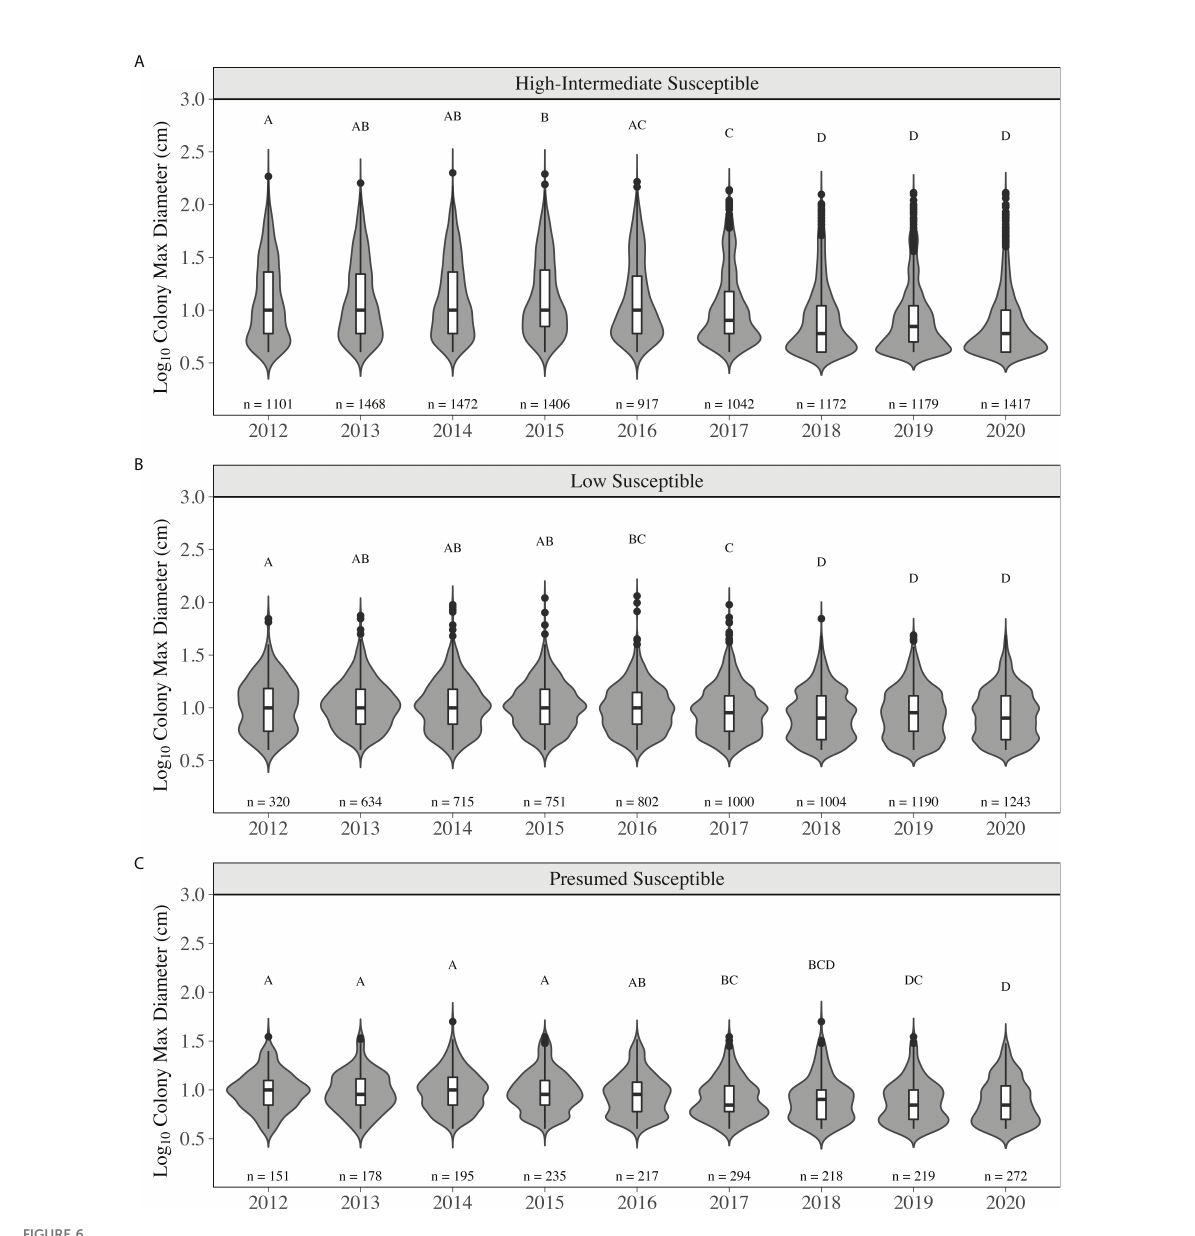
FIGURE 6 Colony max diameter from 2012-2020 for stony coral species based on SCTLD susceptibility categorization for (A) high-intermediate susceptible species (B) low susceptible species and (C) presumed susceptible species. Numbers above each year are the total number of stony coral colonies observed belonging the respective susceptibility category. The grey areas indicate the kernel density distribution of maximum colony diameter, where the wider the plot is the higher the probability that members of the population will take on that given value and skinnier sections have lower probabilities. The inset boxplots represent the median (solid middle bars), interquartile range (box length), and maximum and minimum values (whiskers) of colony maximum diameter. Data points that fall outside the boxplot are considered outliers. Different letters above the violins indicate signi fi cant differences in maximum colony diameter between years (p < 0.05, KS